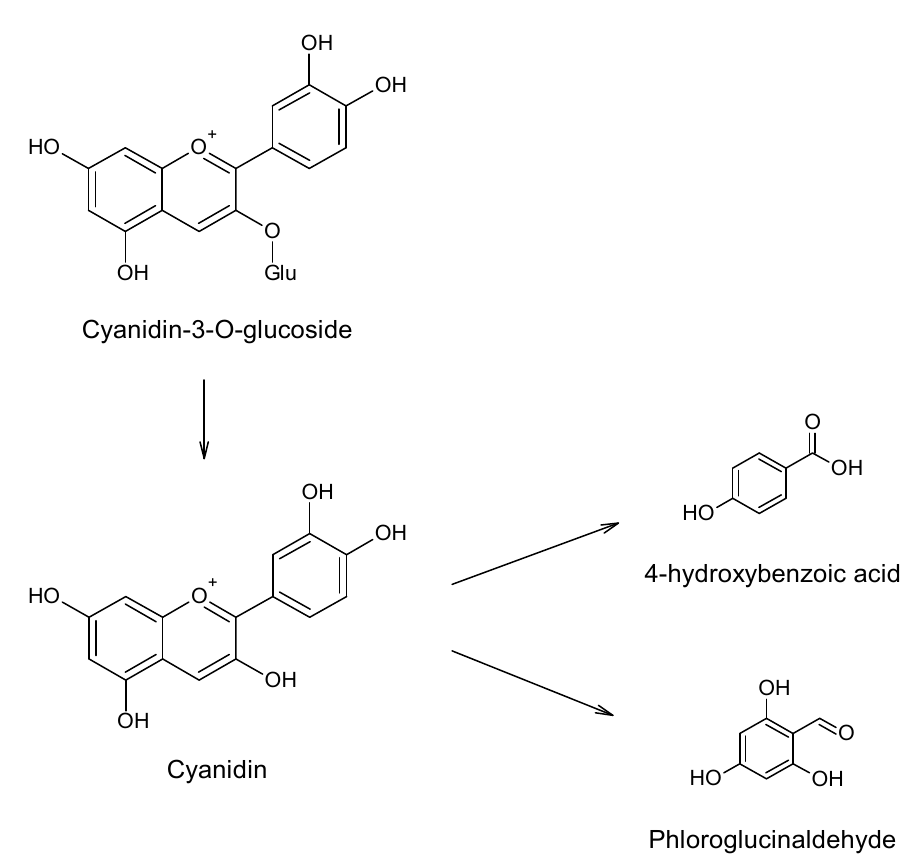
Figure 5. Degradation mechanism of cyanidin-3-O-glucoside subjected to plasma treatment [92].